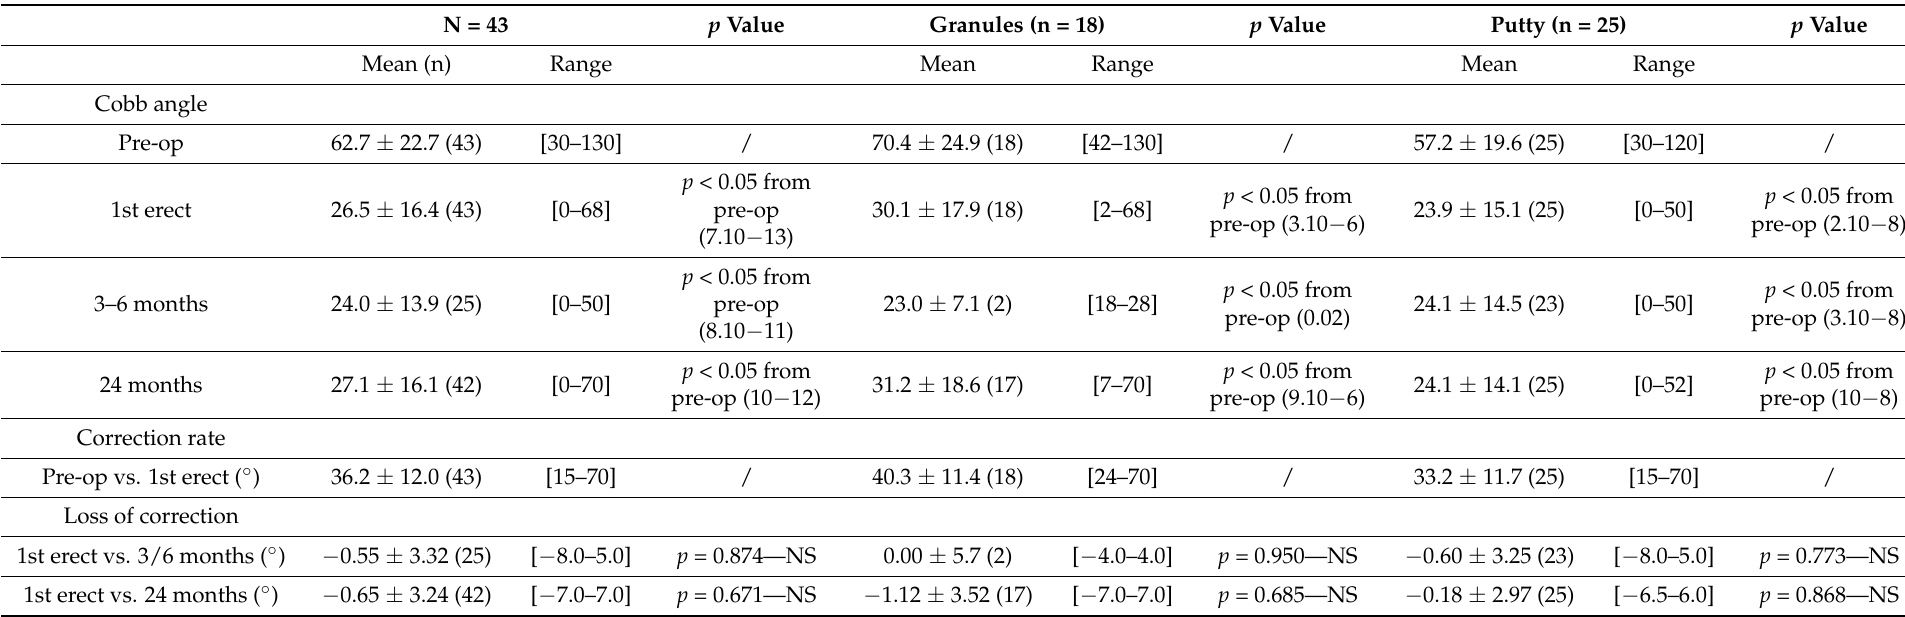
Table 3. Radiographic data (Cobb angle, correction rate, loss of correction). NS: Not